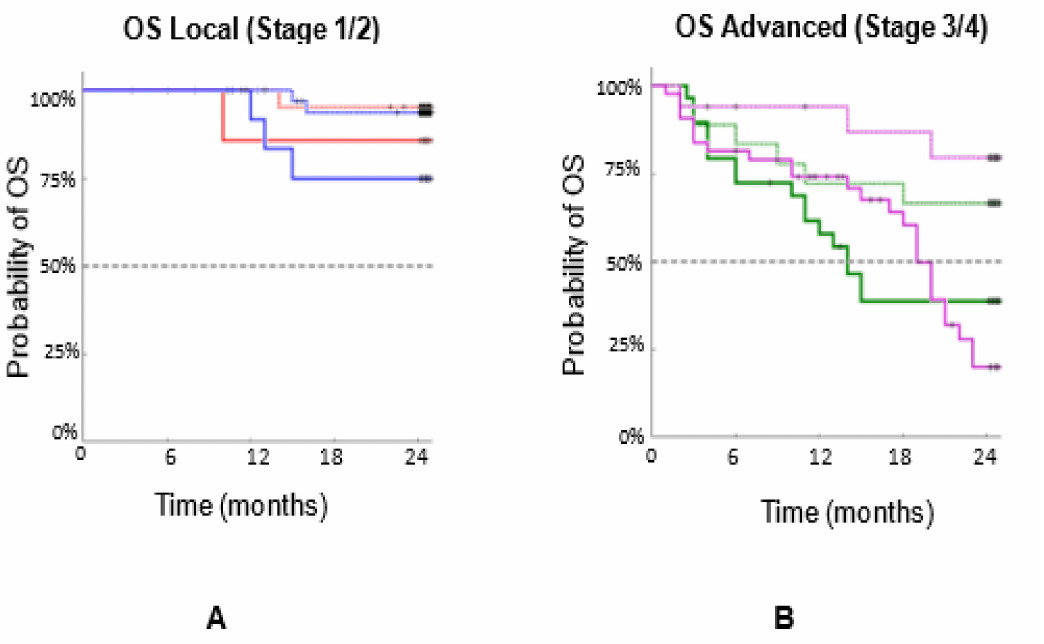
Figure 8. OS of n = 192 patients with three types of cancers (breast, prostate, and lung) by stage. OS based on CAML size, combining ( A ) Stages 1,2 (merging Figure 6A,B), and ( B ) Stages 3,4 (merging Figure